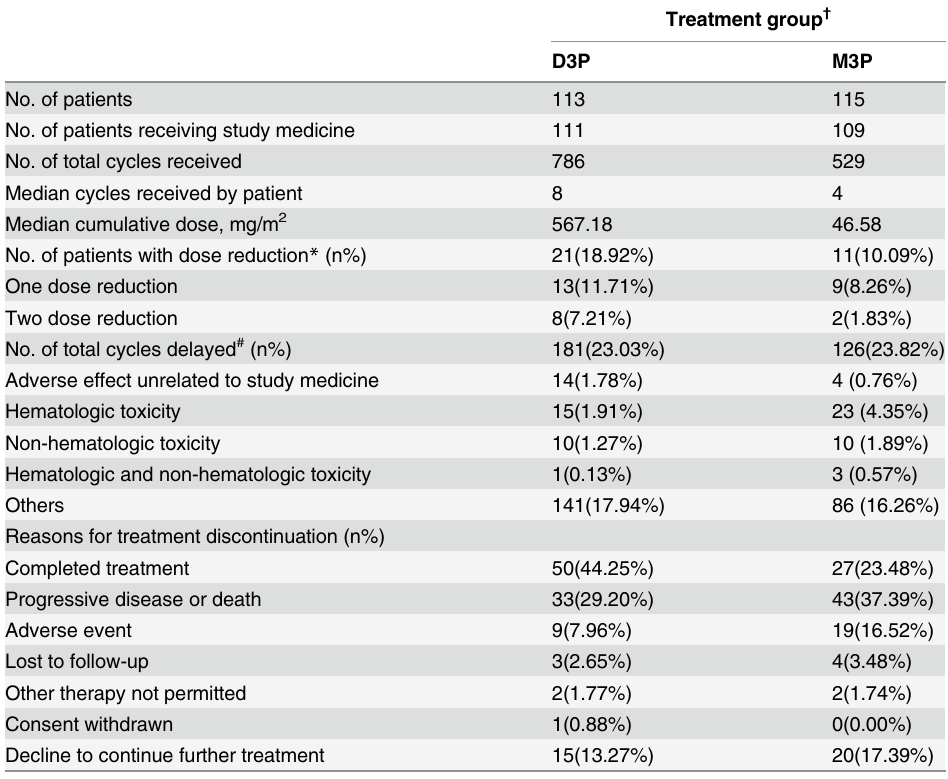
Table 2. Drug delivery and reasons for treatment